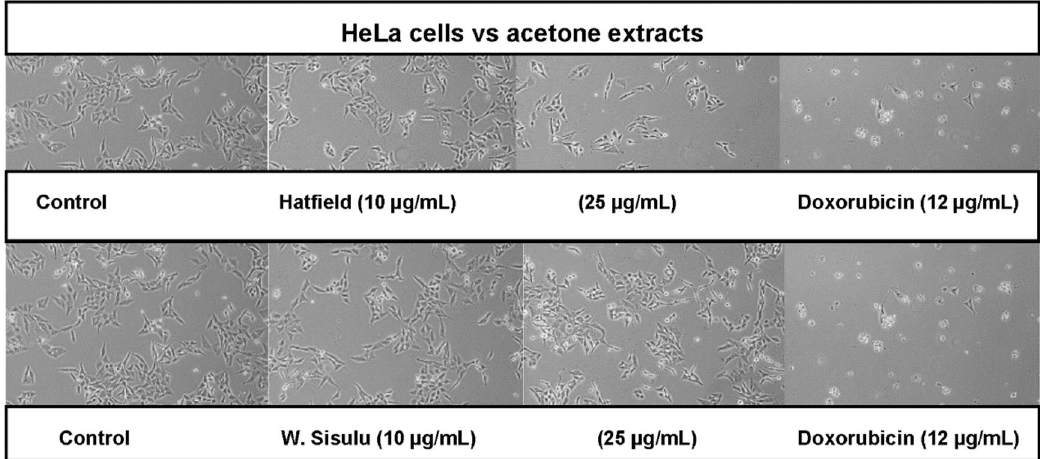
Figure 2. Morphological characterization of HeLa cell line treated with 10 and 25 µg/mL of Hatfield and Walter Sisulu acetone crude extracts, and 12 µg/mL doxorubicin for 48 h.